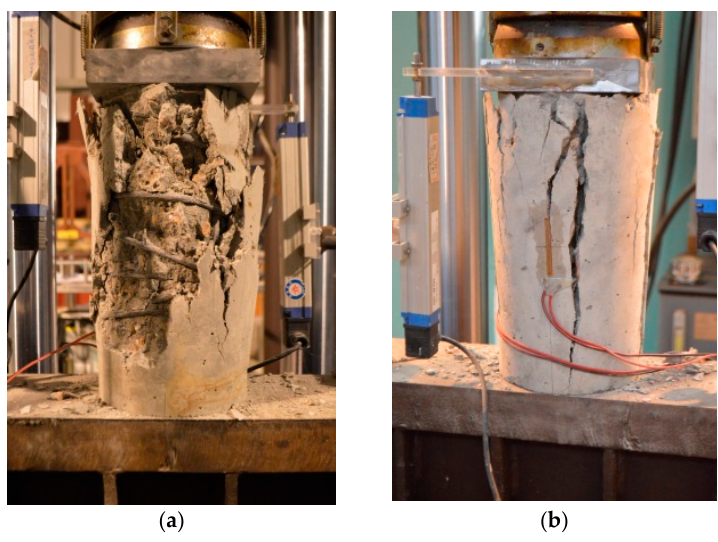
Figure 5. Failure patterns: ( a ) stirrup-confined concrete specimen (C2S3Y1); and ( b ) unconfined concrete specimen (C1S0Y0).